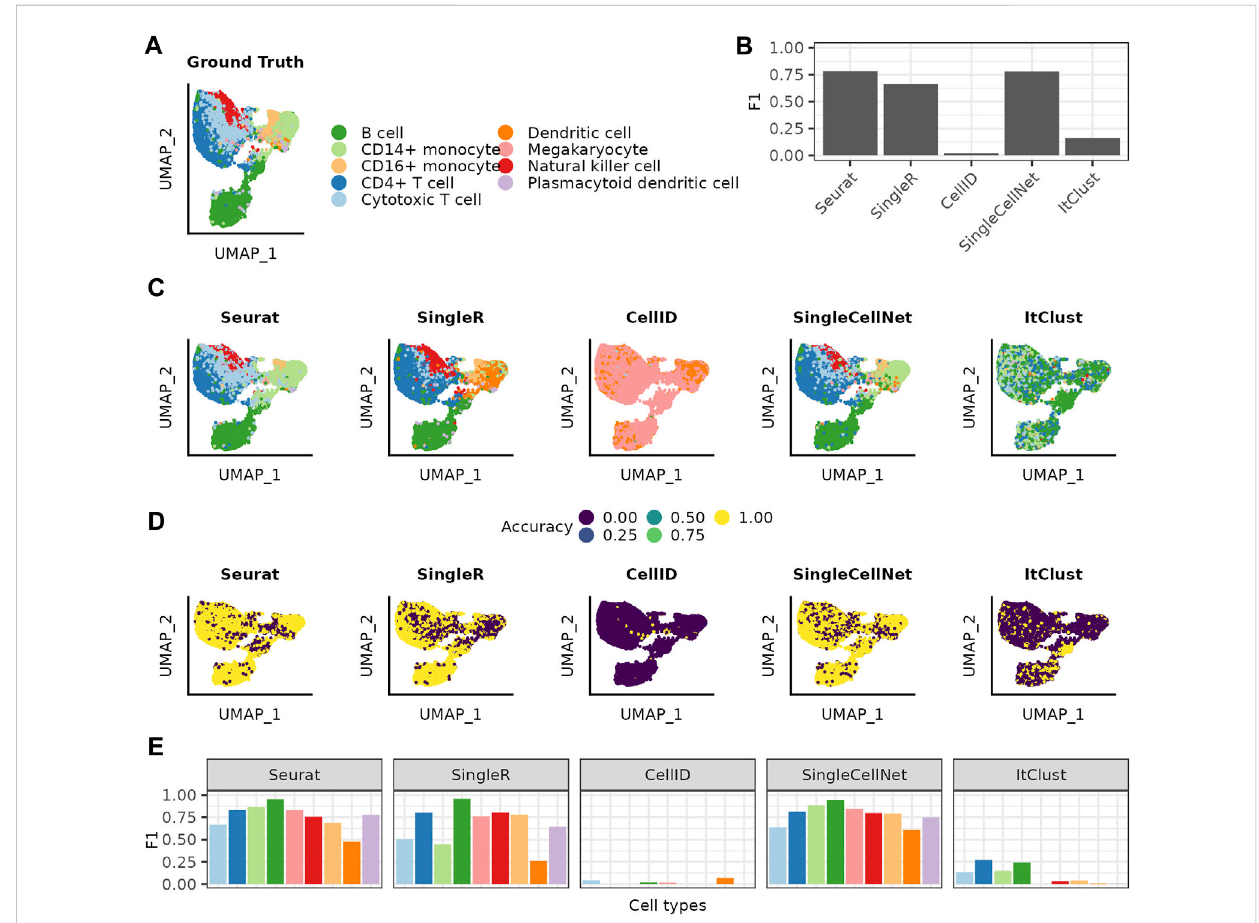
FIGURE 1 Cell type label transfer on the PBMC dataset using the full reference dataset. (A) UMAP of the query cells colored based on the cell types assigned in the ground truth. (B) Over all F1 scores achieved for each of the methods. (C) UMAPs colored by the cell type annotation made with the